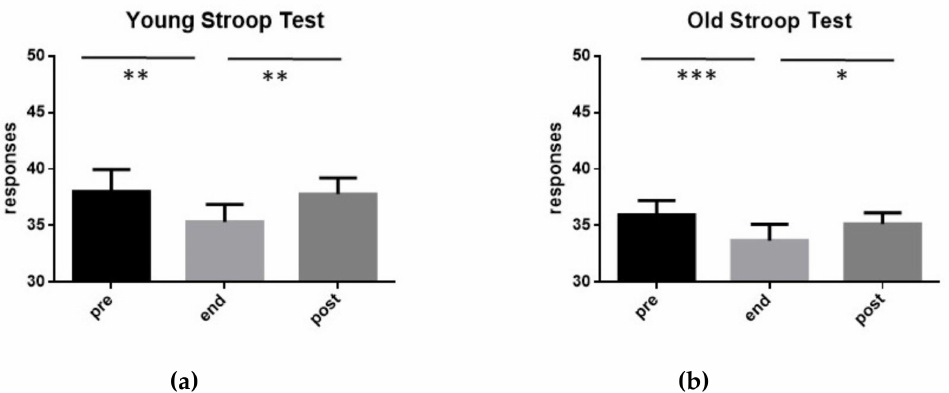
Figure 3. Values of SCWT mean score exhibited by the 15 subjects of group YOUNG ( a ) and by the 15 subjects of group OLD ( b ) performing an exhaustive exercise. In both cases, SCWT mean score measured before the exercise (pre), at its conclusion (end), as well as 15 min after its end (post) are shown. Symbols from ANOVA with Dunn’s multiple comparison test: * p < 0.05, ** p < 0.01, *** p <